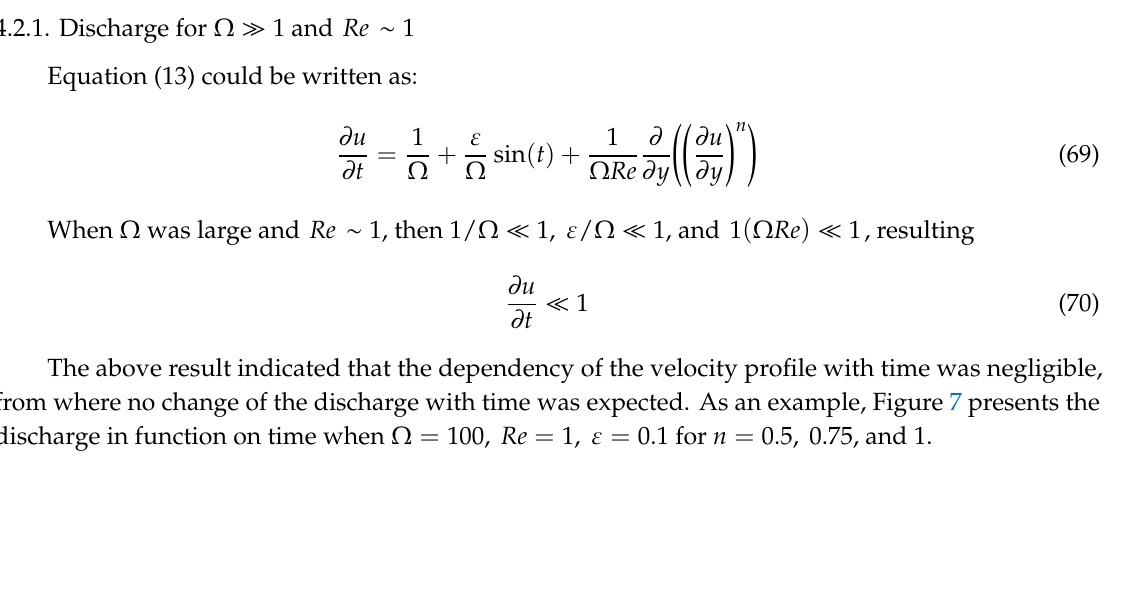
Figure 6. Wall shear stress for  = 1 , 𝑅𝑒 = 0.1 , 𝜀 = 0.1 .